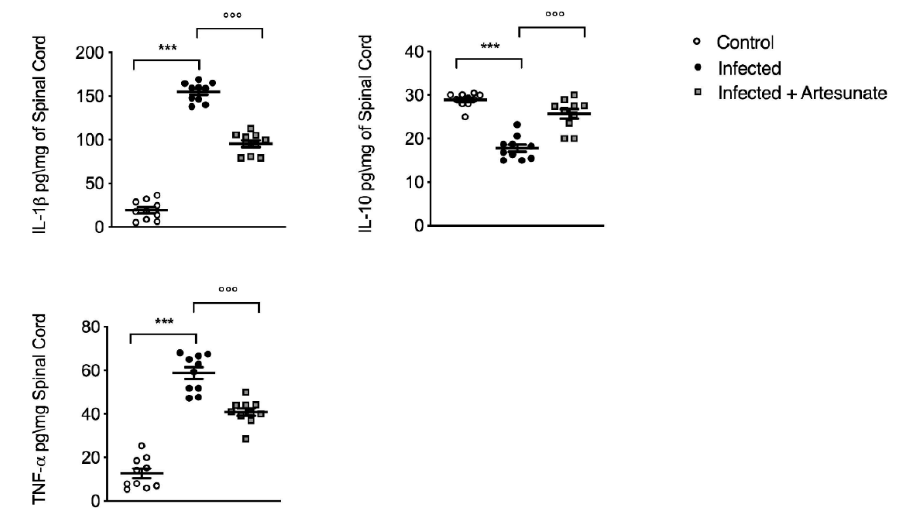
Figure 5. ELISA assay for IL-1 β , IL-10, and TNF- α in lumbar spinal cord tissue. Data are expressed as mean ± SEM from N = 10 mice for each group. *** p < 0.001 vs. control group; ◦◦◦ p < 0.001 vs. infected group.